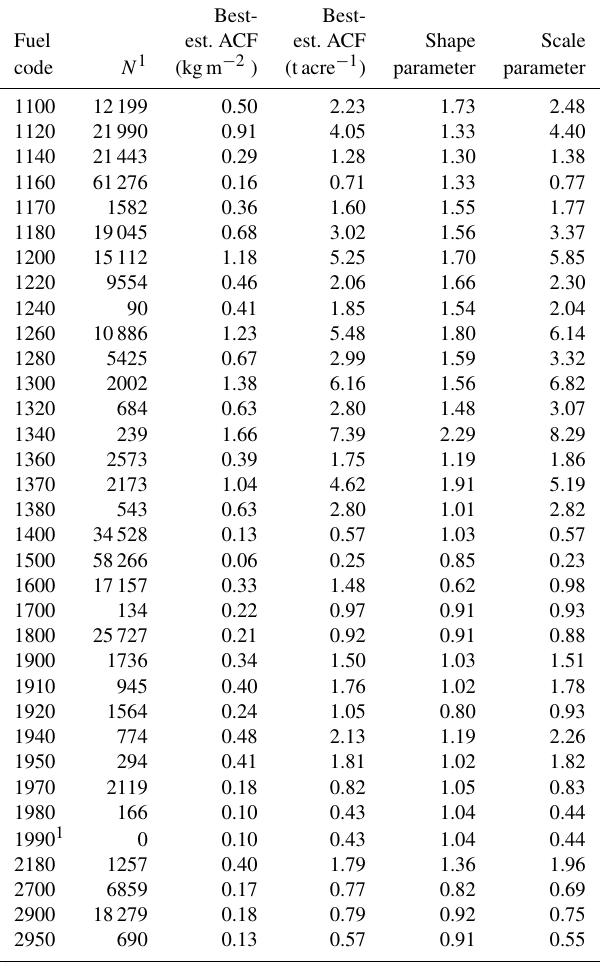
Table B1. ACF best estimates (see Sect. 2.4.1) and optimized pa- rameters for Weibull PDF fits. Parameters predict ACF in units of tacre − 1